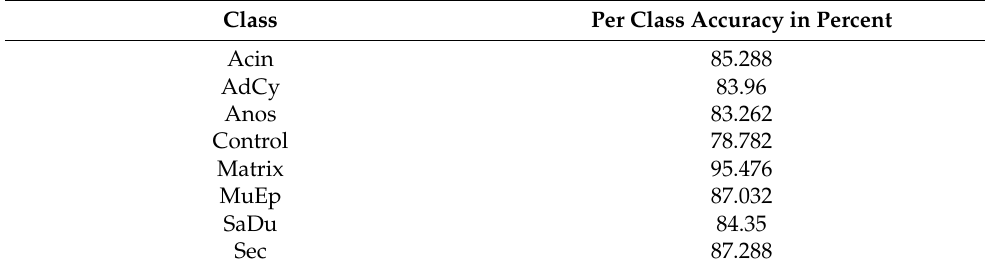
Table 2. Per-class accuracy of our deep-learning approach averaged on all test sets.